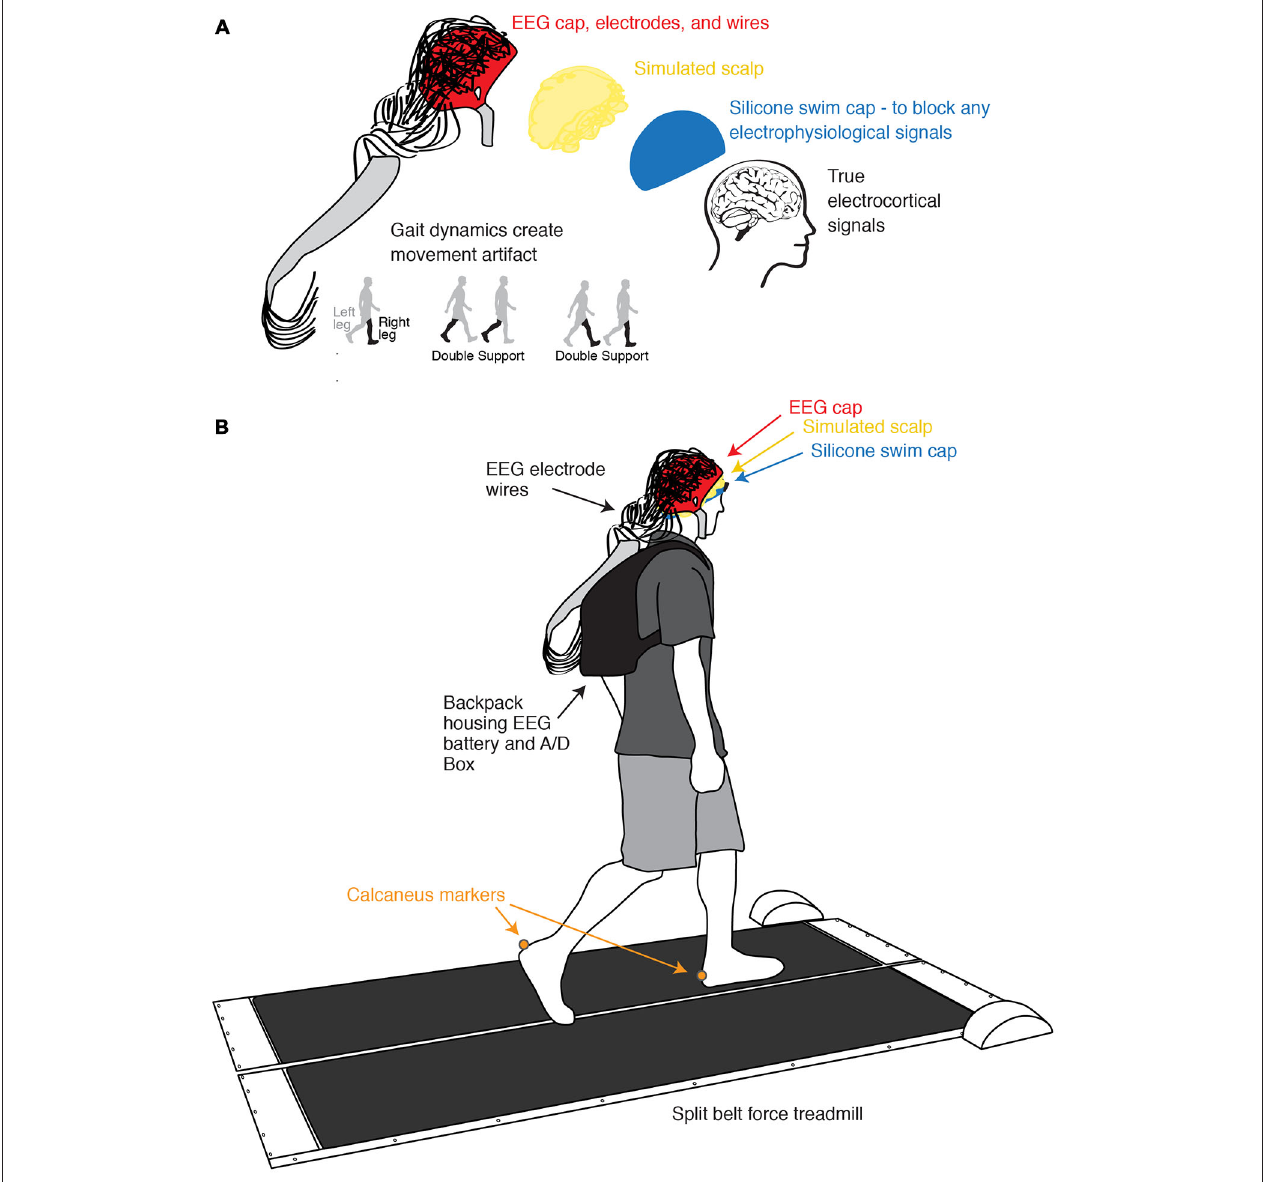
FIGURE 1 | Experimental setup and channel location illustration. (A) Illustration of the process of isolating and measuring gait-induced movement artifact in EEG recordings. A simulated conductive scalp permits the electrodes to measure voltage differences resulting from gait dynamics while a silicone swim cap blocks true electrocortical signals. (B) Schematic of experimental setup and channel locations. Subjects walked on a custom split-belt force measuring treadmill at four speeds (0.4, 0.8, 1.2, and 1.6 m/s). Calcaneus marker positions were recorded using motion